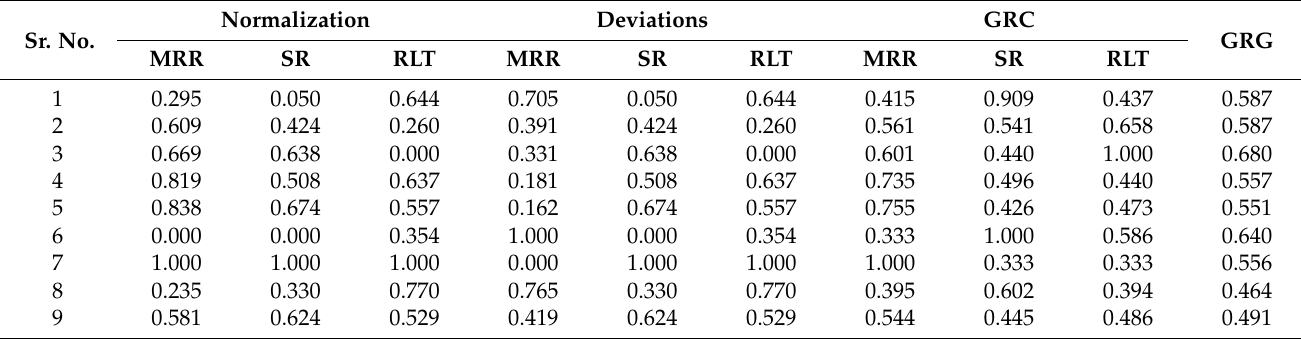
Table 4. Obtained values from normalization, GRC, and